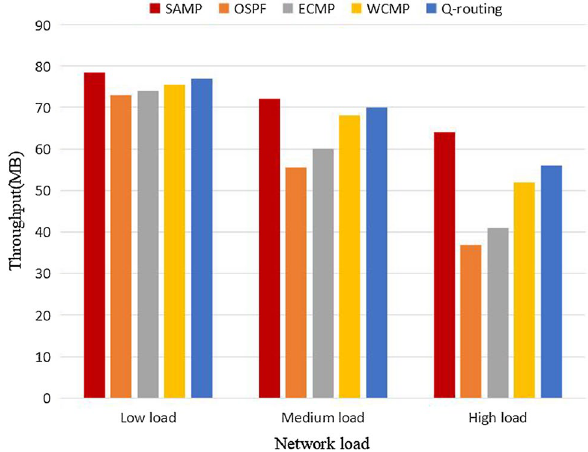
Fig. 12 Throughput under different network